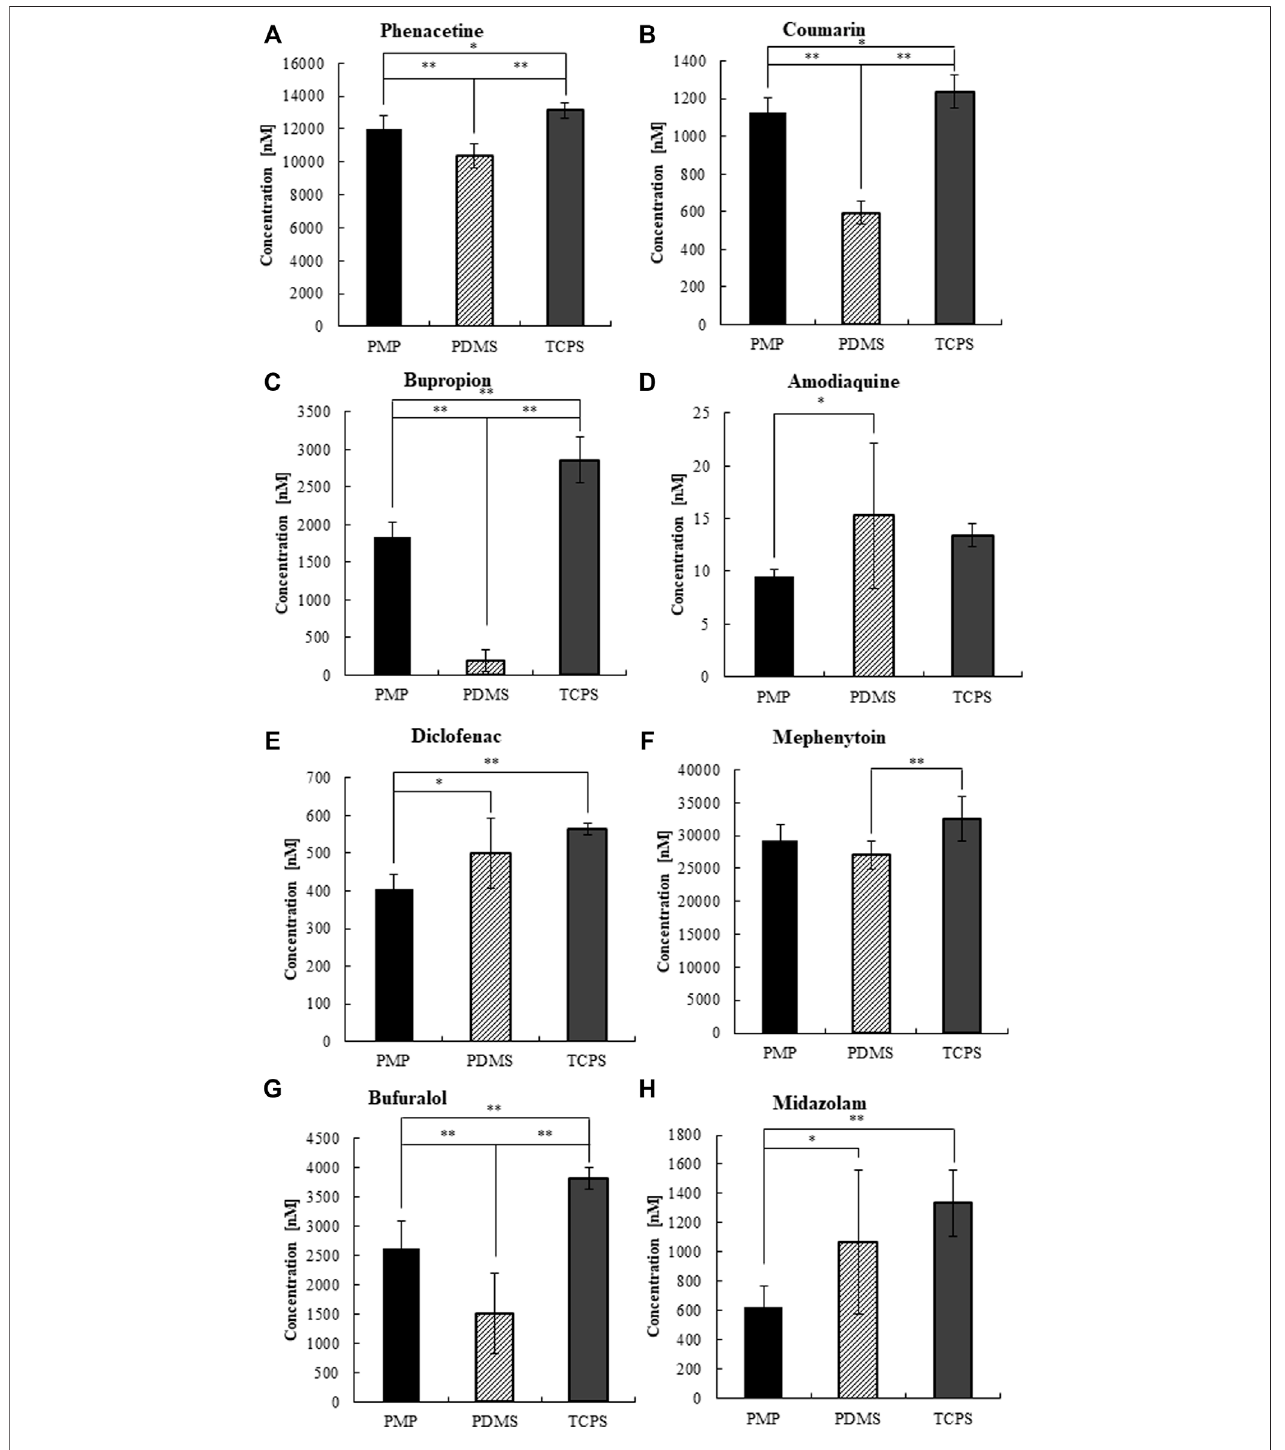
FIGURE 7 | The concentrations of CYP substrates at 4 h of exposure to cultured hepatocytes on day 7. (A) CYP1A2, (B) CYP2A6, (C) CYP2B6, (D) CYP2C8, (E) CYP2C9, (F) CYP2C19, (G) CYP2D6, and (H) CYP3A2 (N = 8).